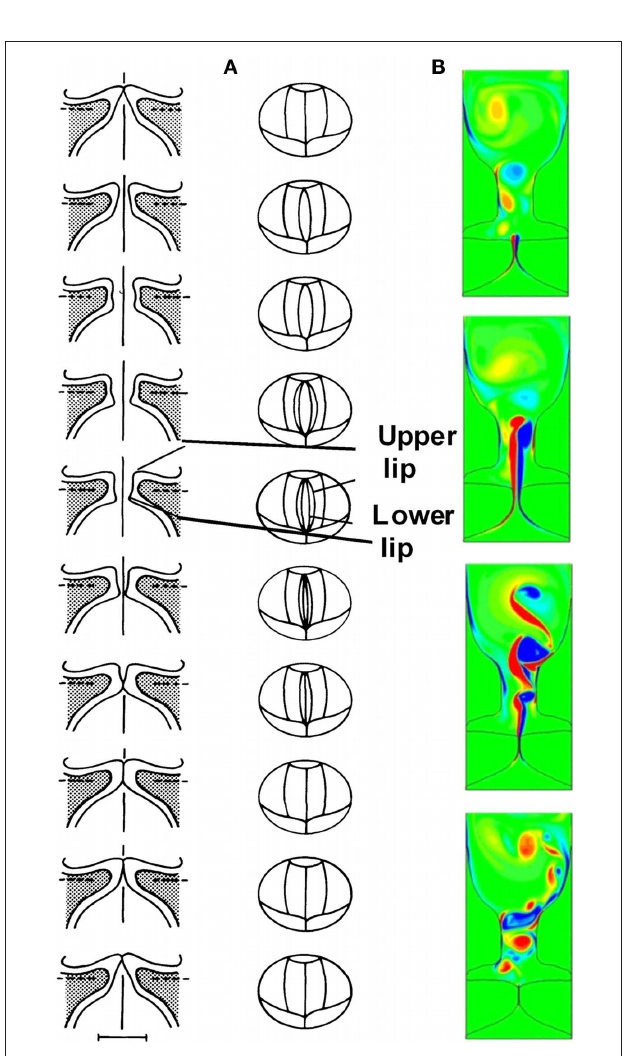
Figure 2 | (A) Flow-induced vibrations in vocal folds (B) Glottal jet is produced due to vocal folds vibration (Zheng et